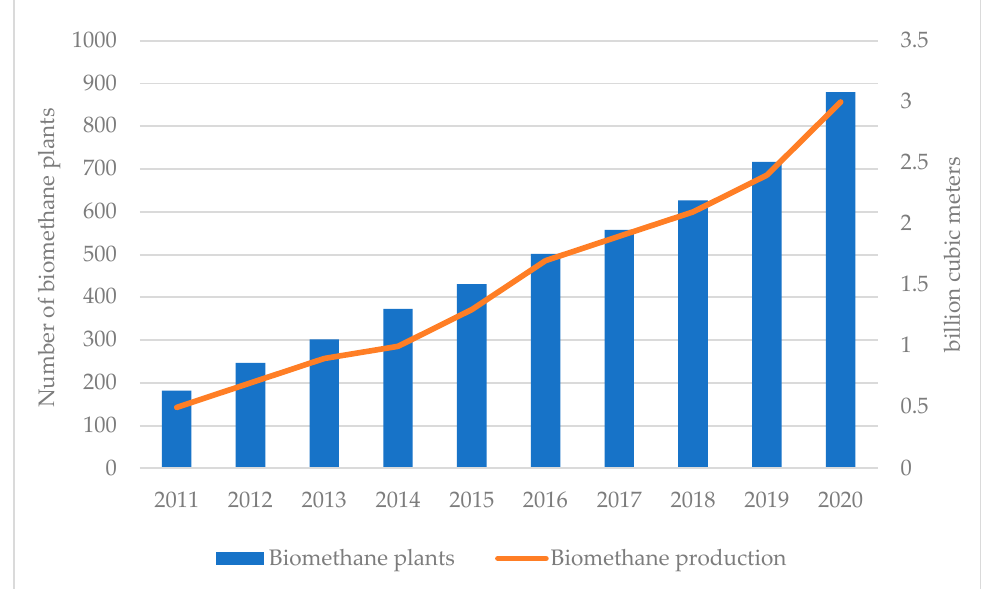
11 of 36 Figure 3. Scheme of REPower EU’s biomethane target realization. Source: own elaboration. 4. Biomethane Market in EU—Current Situation and Development Potential 4.1. Current Situation The European Union is currently the largest producer of biomethane in the world and has significant potential for further development [25,80]. The first biomethane plant in Europe was probably established in the UK in 2009 [81]. Since then, the number of bio- methane plants has increased significantly, and in 2020, almost 900 installations were pro- ducing 3.3 bcm biomethane (32 TWh). However, the 32 TWh of biomethane produced in the EU in 2020 accounted for only 17% of the total biogas production of 191 TWh [82,83].